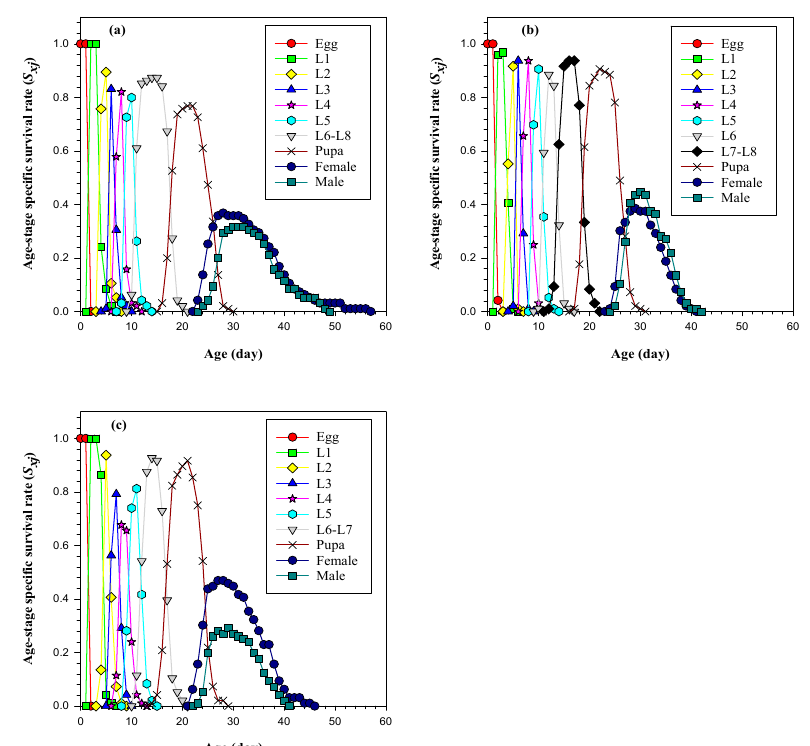
Figure 2. Age-stage speci fi c survival rate of FAW on ( a ) napier grass, ( b ) natal grass, and ( c ) sunn hemp. The age-speci fi c survival rate ( l x ) of FAW population gradually declined as the age ( x ) of the population increased. In the fi rst 20 days, the l x curve diminished from 100% to